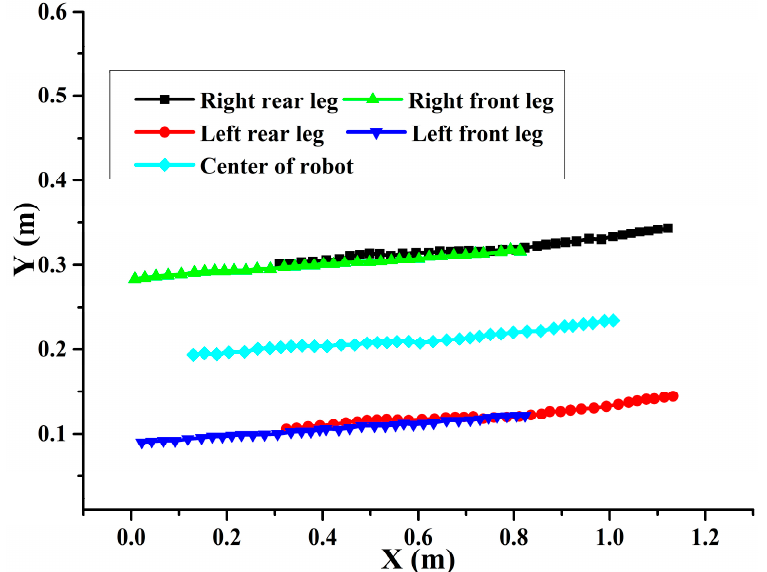
Figure 18. The path of the robot’s progress locomotion within 6 s. The five lines express five feature points on the legs and the center of the robot.